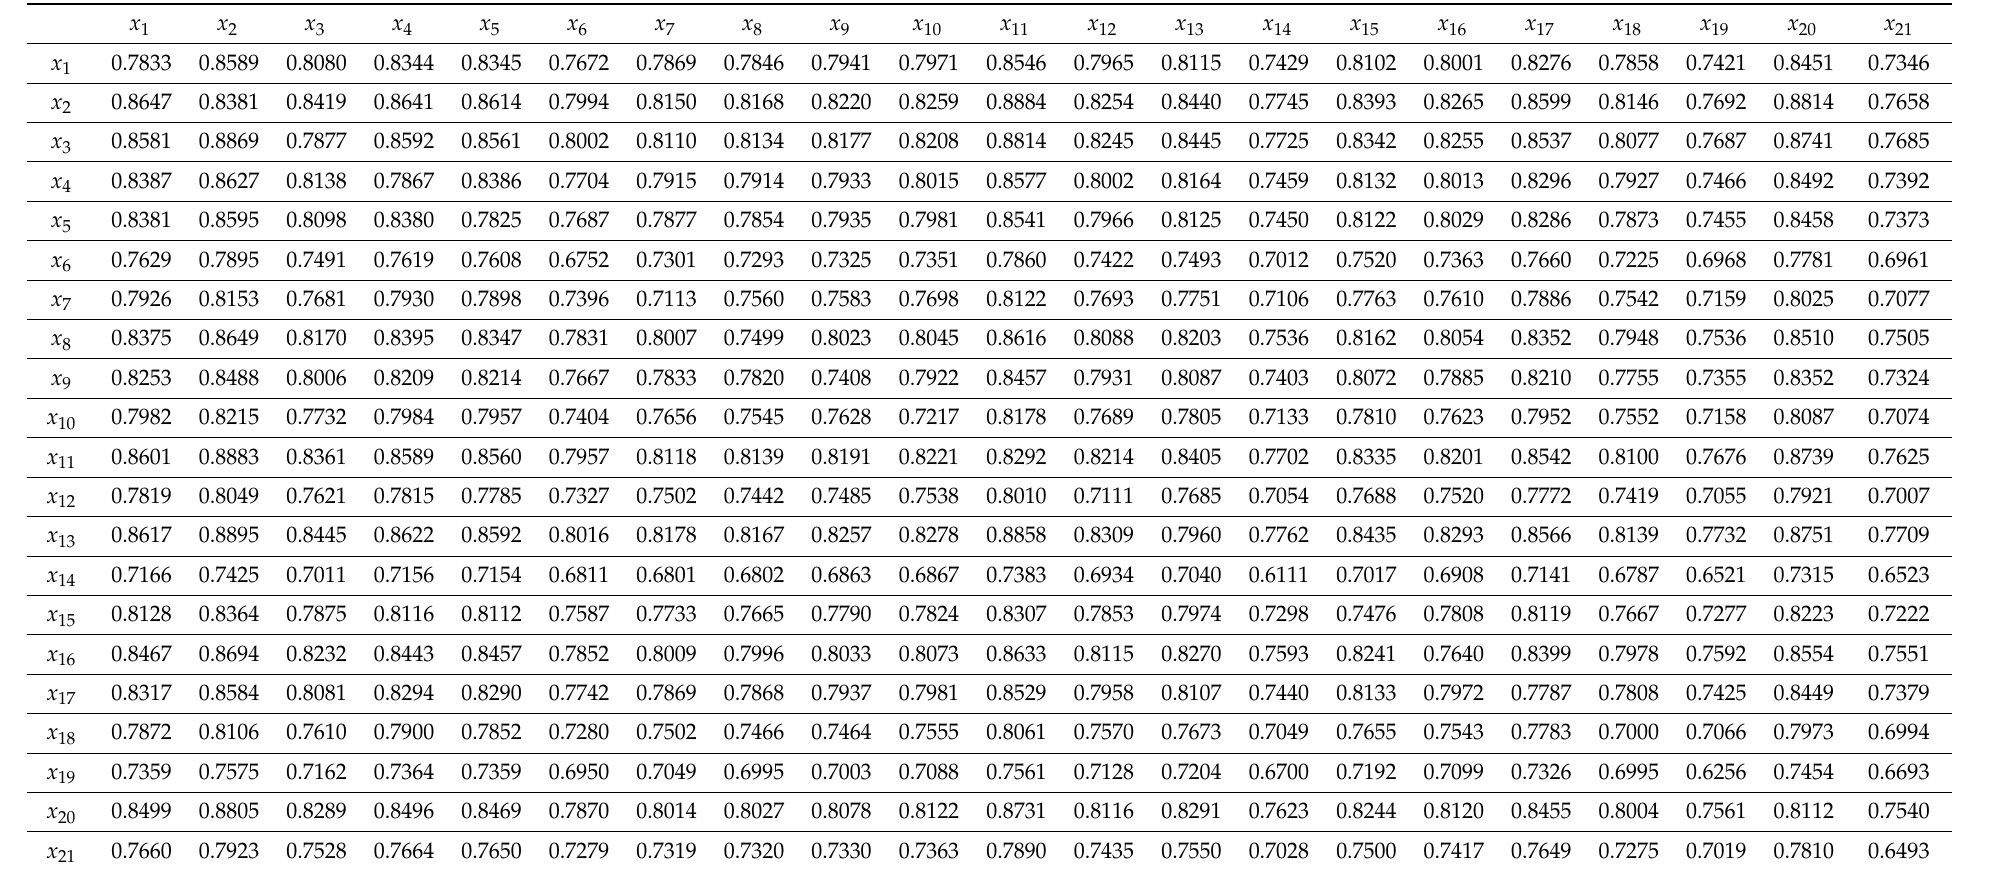
Table A4. The total influence